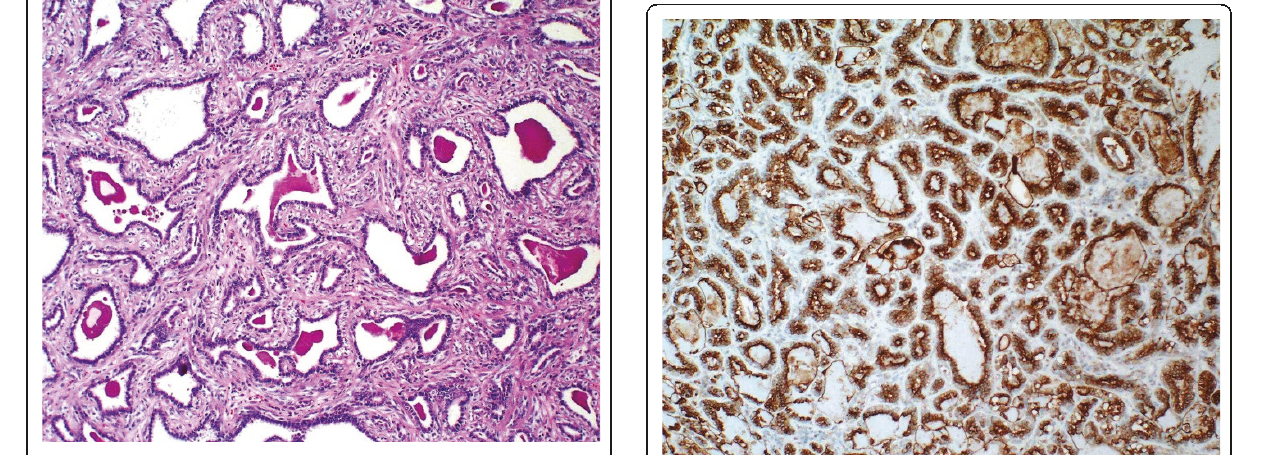
Figure 1 Neoplastic cells form tubular structures mixed with little cysts and scarce solid areas .